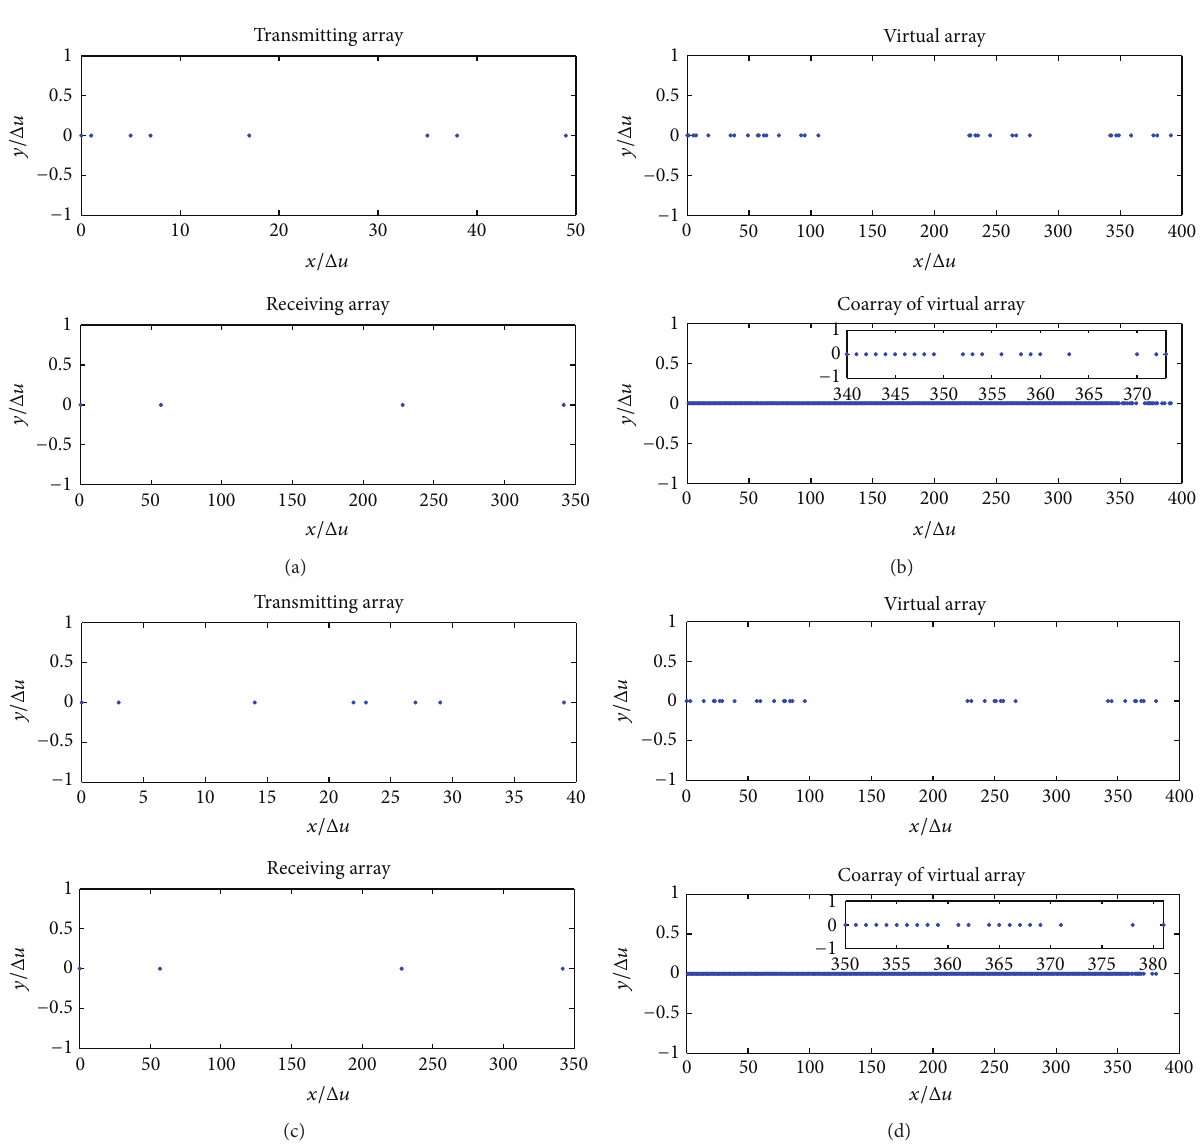
virtual array are outside the [0, 𝐿] segment. This